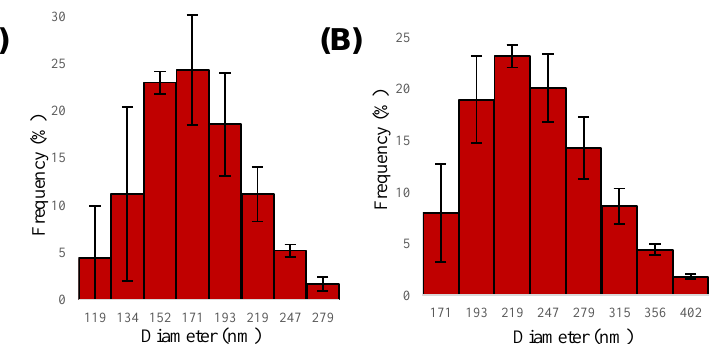
Figure 4. Size profiles of nanoparticles from PLGA derivatives, measured by DLS. ( A ) Glucoconjugate 28 . ( B ) Coumarin-containing derivative 29 .